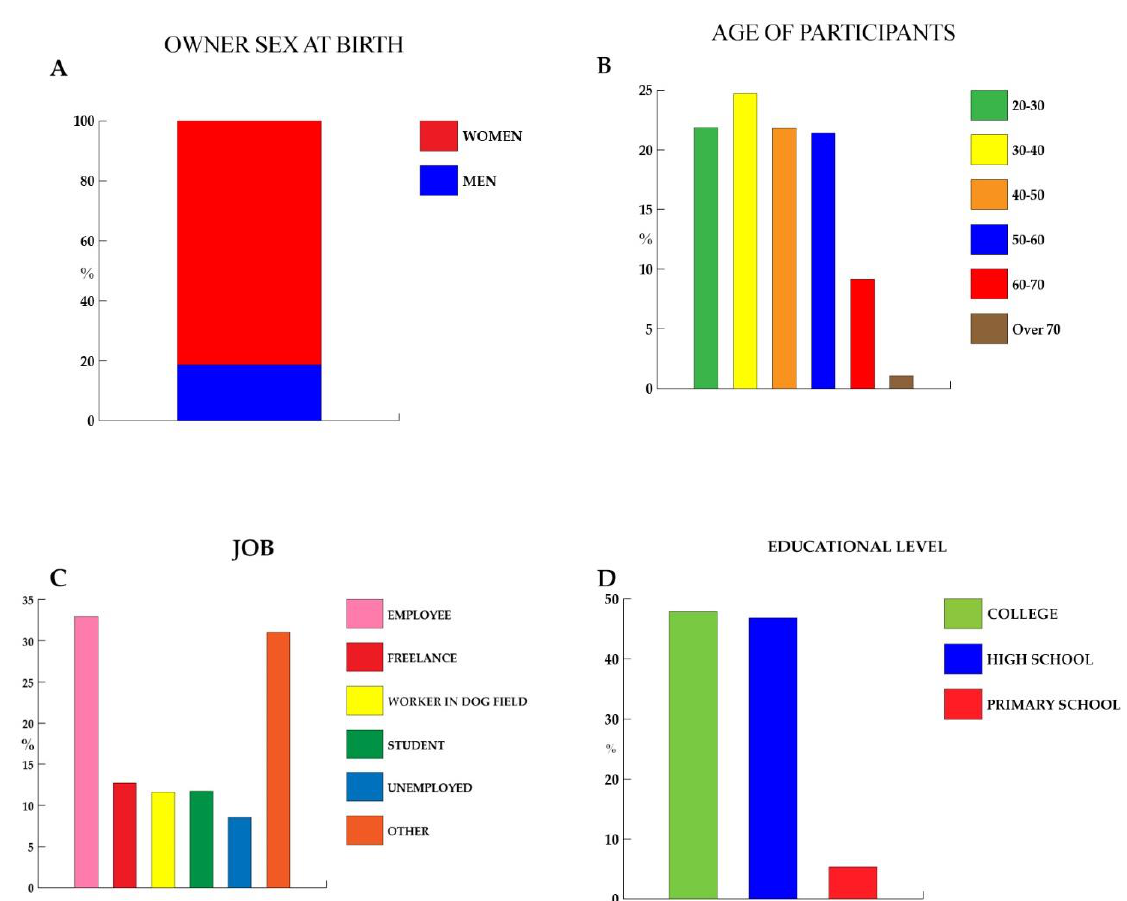
Figure 1. Information on dog owners. ( A ) Participants’ sex; ( B ) participants’ age; ( C ) participants’ job; ( D ) participants’ degree. Data are expressed in percentage.